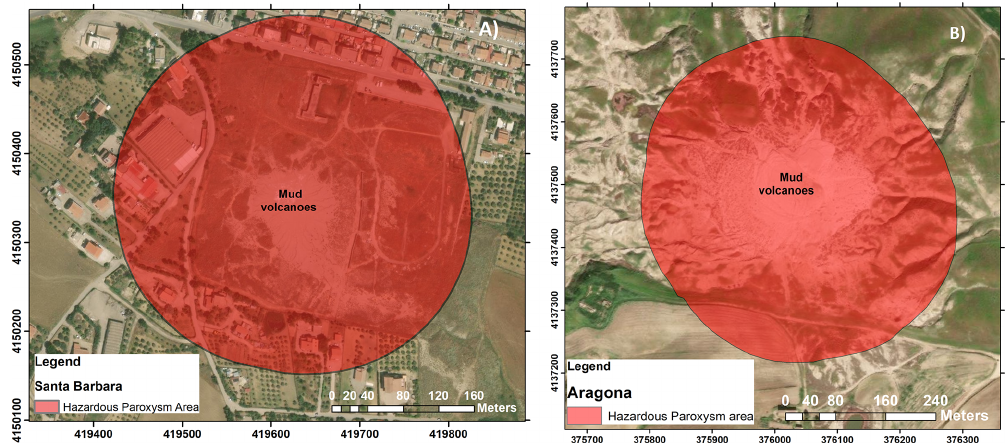
Figure 7. Hazardous paroxysm areas in ArcGis 10.5 for the Santa Barbara (A) and Aragona (B) mud volcano areas (source image from ArcGIS 10.5,